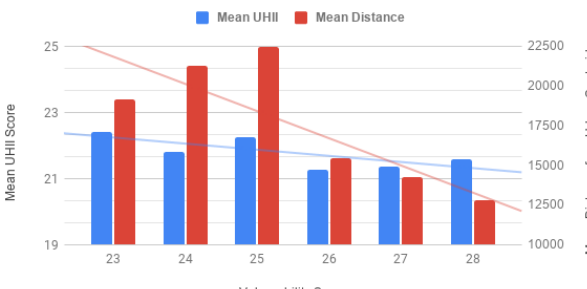
Figure 10 - Mean UHII and distance from Phoenix’s urban center for blocks with the top 25% of vulnerability scores.